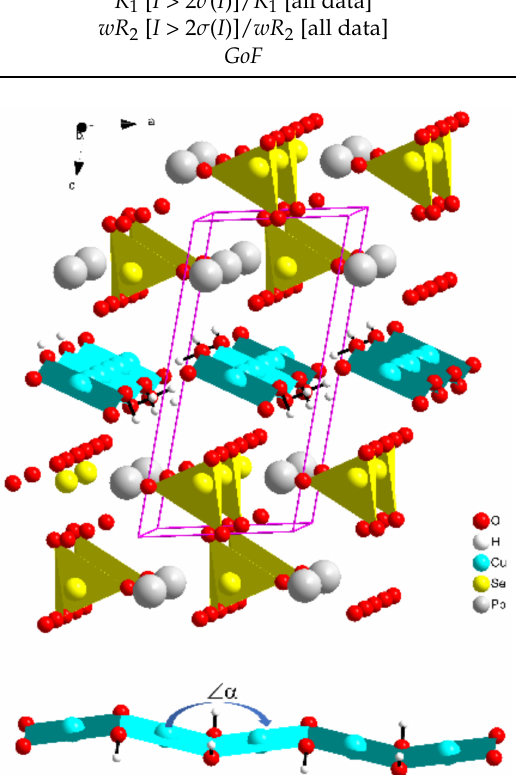
Figure 1. The crystal structure of PbCu(SeO 4 )(OH) 2 . CuO 4 squares and SeO 4 groups are shown. The chain of CuO 4 squares is shown at the low part of the figure.